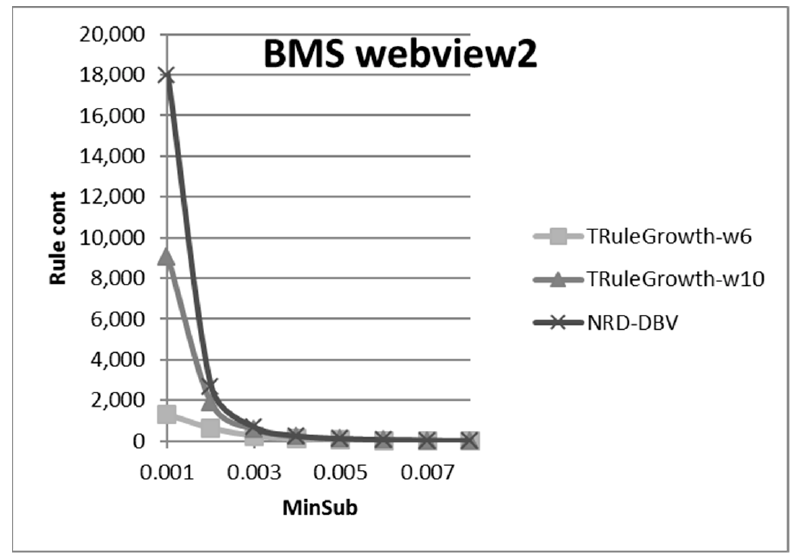
Figure 14. Comparison between the No. of rules generated for the TRuleGrowth and the NRD-DBV for (BMS webview2) dataset.